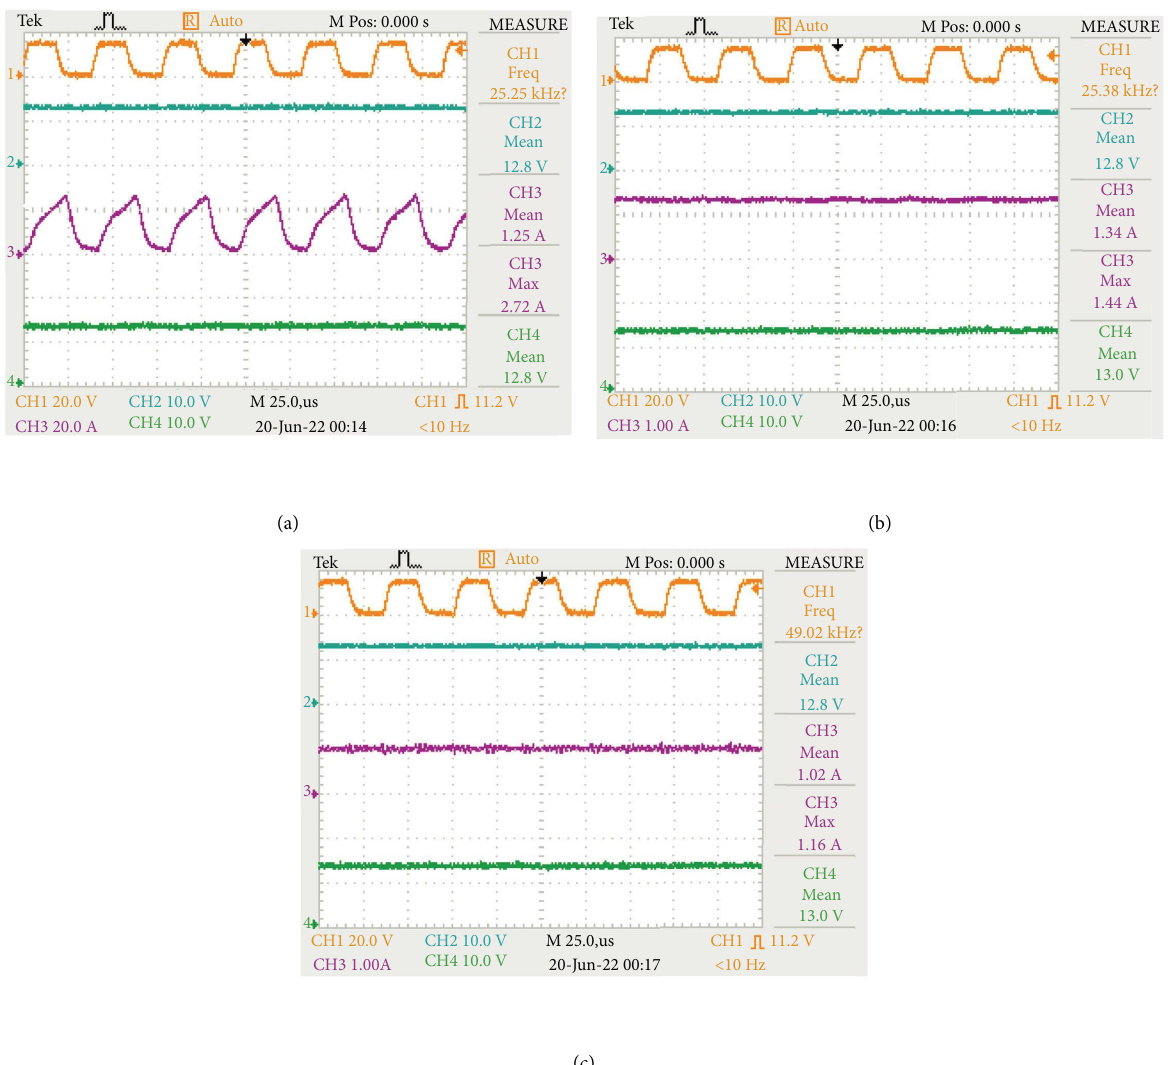
Figure 12: (a) PWM, V in , I L 1 , and V o ; (b) PWM, V in , I in , and V o (c) PWM, V in , I o , and V o Cuk converter with LC flter.